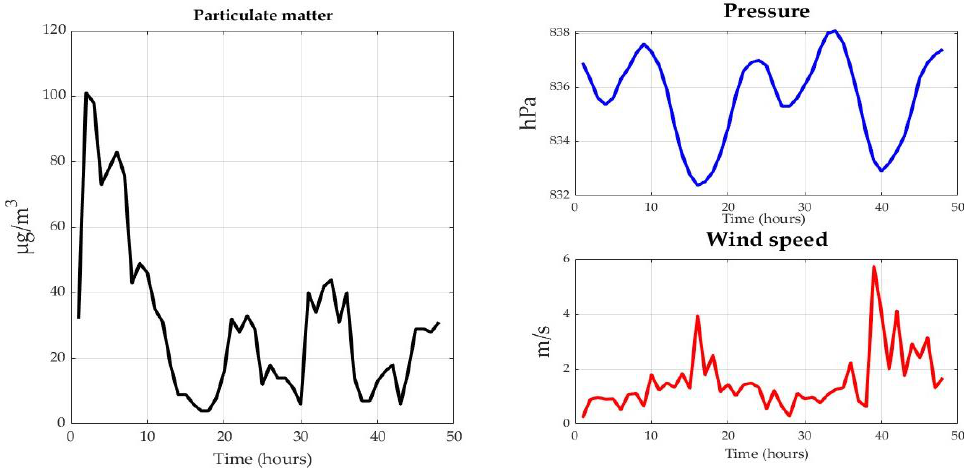
Figure 5. Relationship between particulate matter, pressure, and wind speed.